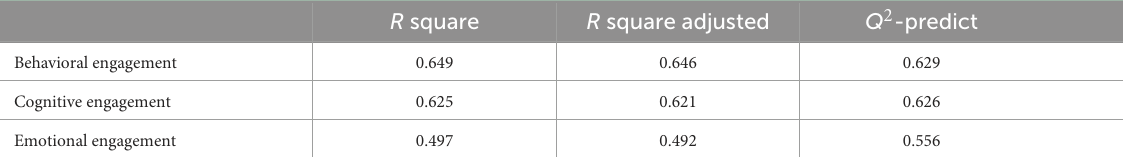
TABLE 6 R square.